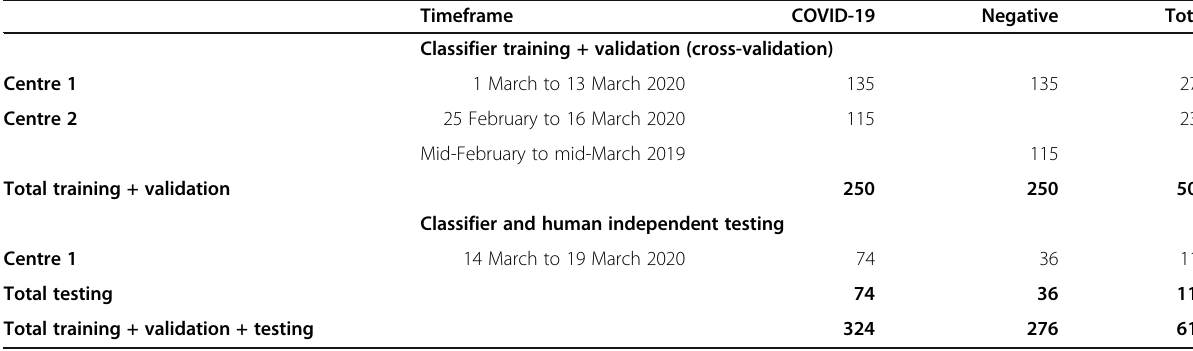
Table 1 Provenience and characteristics of the included chest x-ray exams